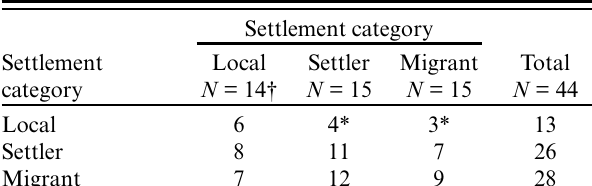
Table 3. Aggregated network tie frequency (number of ties) within and between settlement categories for the study area, Sunyani District, Brong Ahafo Region,